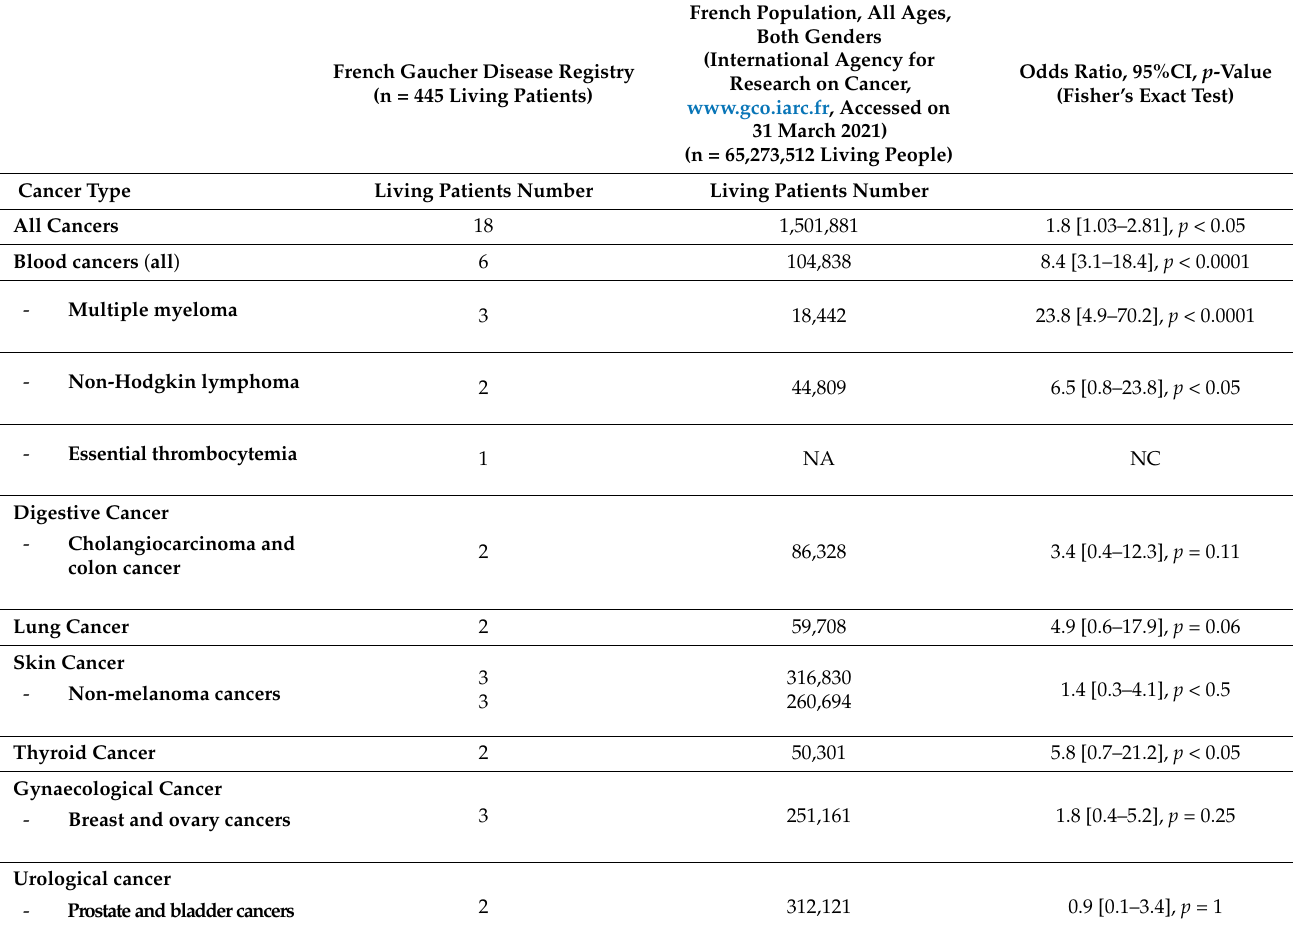
Table 3. Cancer prevalence in the French Gaucher Disease Registry and French population.